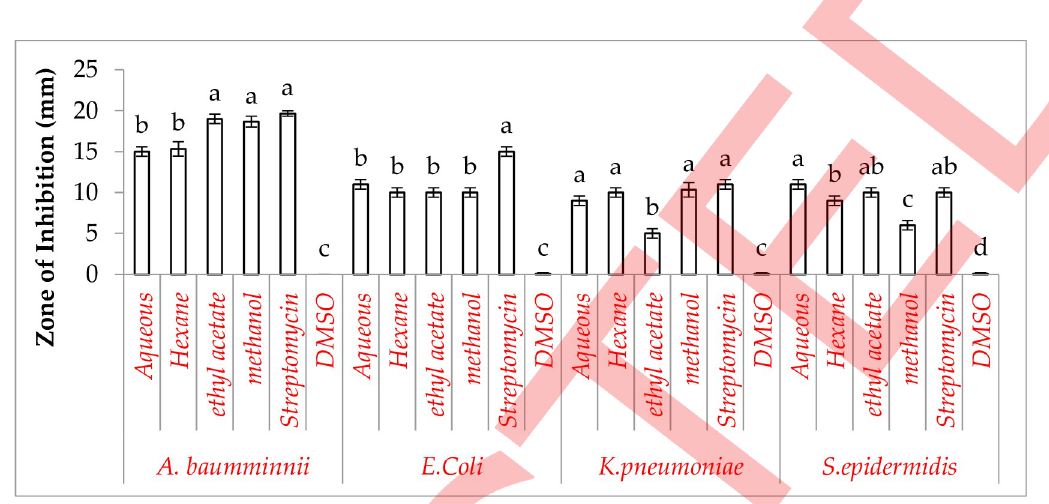
Fig 2. Antibacterial activity of aqueous, methanol, hexane and ethyl acetate extracts of C . glaucum on different strains of bacteria.